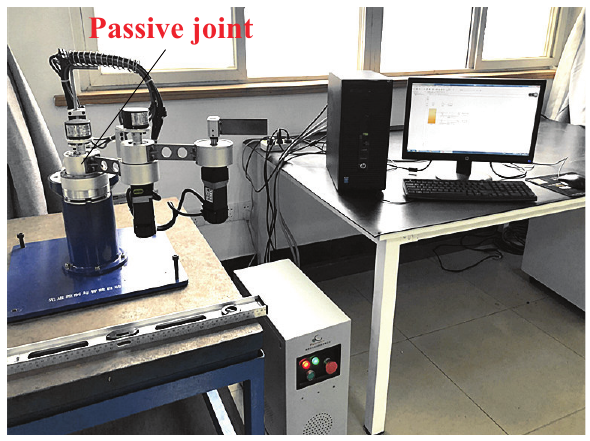
Figure 3. Picture of